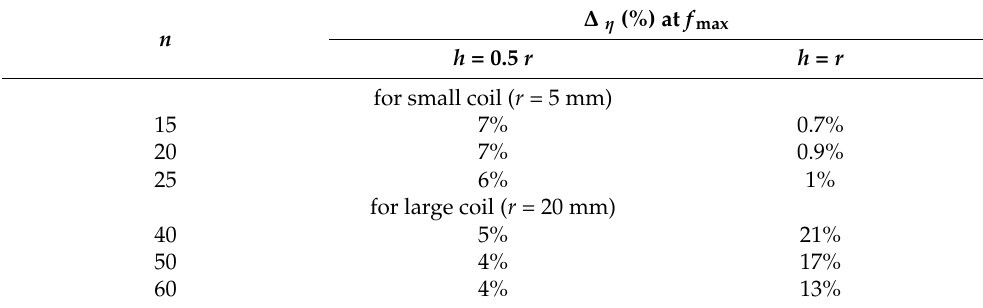
Table 12. The difference between the efficiency of the system in the periodic models with circular or square coils. n